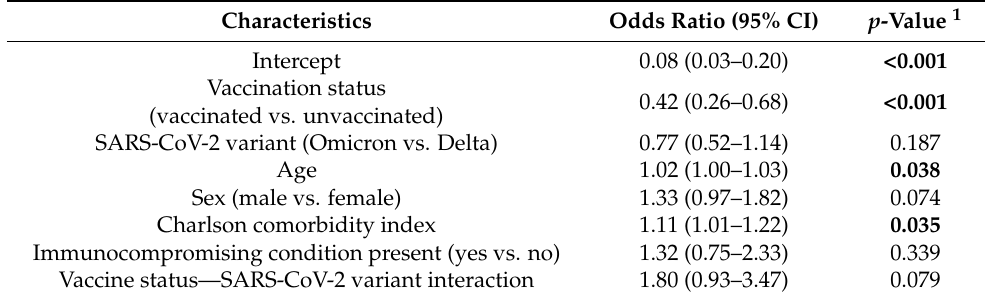
Table 2. Association between prior vaccination against SARS-CoV-2 and progression to critically severe disease (the World Health Organization’s COVID-19 Clinical Progression Scale 7–10) [21].